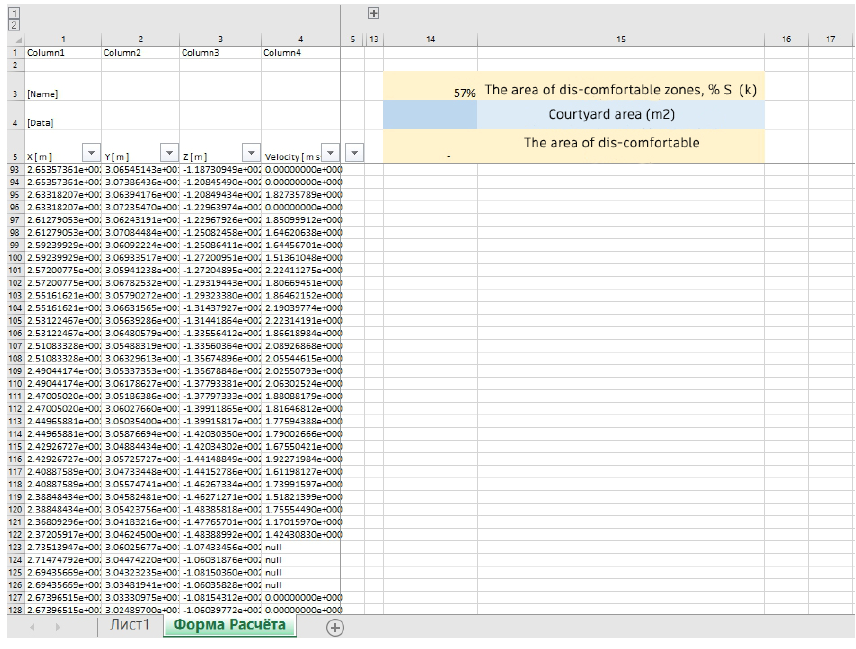
Figure 11. An example of the wind velocity database in the .csv format that demonstrates the share of discomfortable zones.